Question: Write a single sentence explaining what this figure depicts.
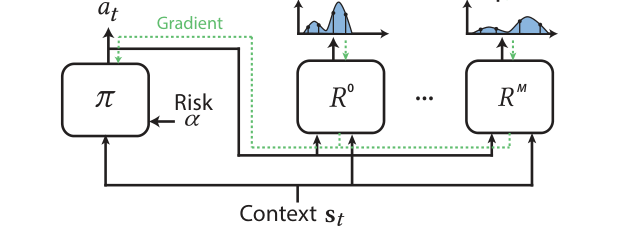
Answer: Risk aware decision-making framework comprising a deterministic actor, M +1 distributional critics and the aggregation function detailed in eq. (7). The propagation of the gradient to train the actor is shown in green.